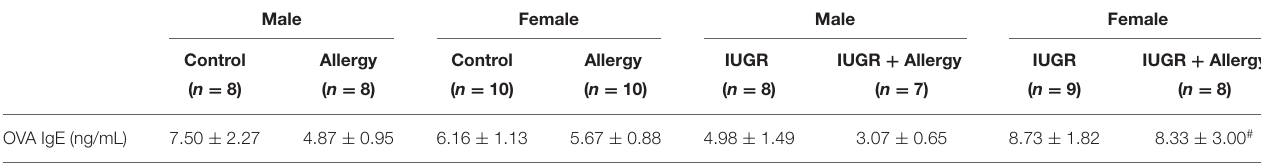
TABLE 1 | OVA IgE levels.